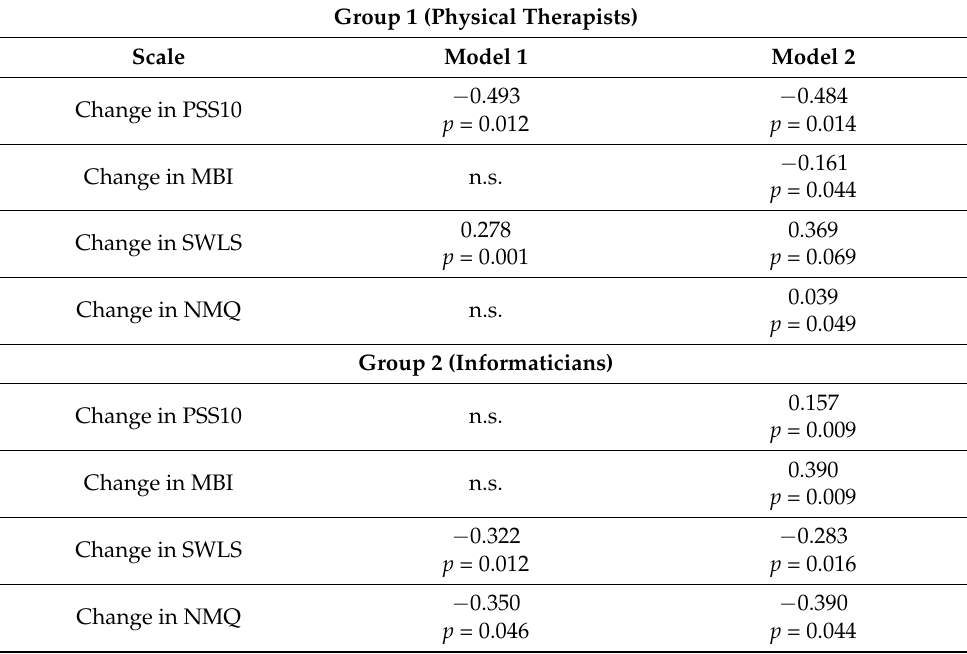
Table 9. Verification of models: correlations between their results and change intest outcomes.